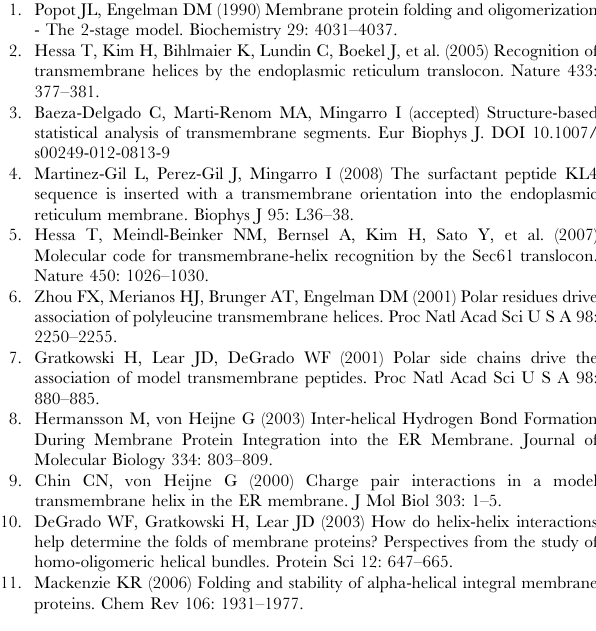
Figure S1 TM segments and flanking residues sequenc- es. The primary sequences of the GpA TM regions used in both the SDS-PAGE and ToxCAT analyses are shown. Hydrophobic residues are boxed in yellow and flanking residues are highlighted